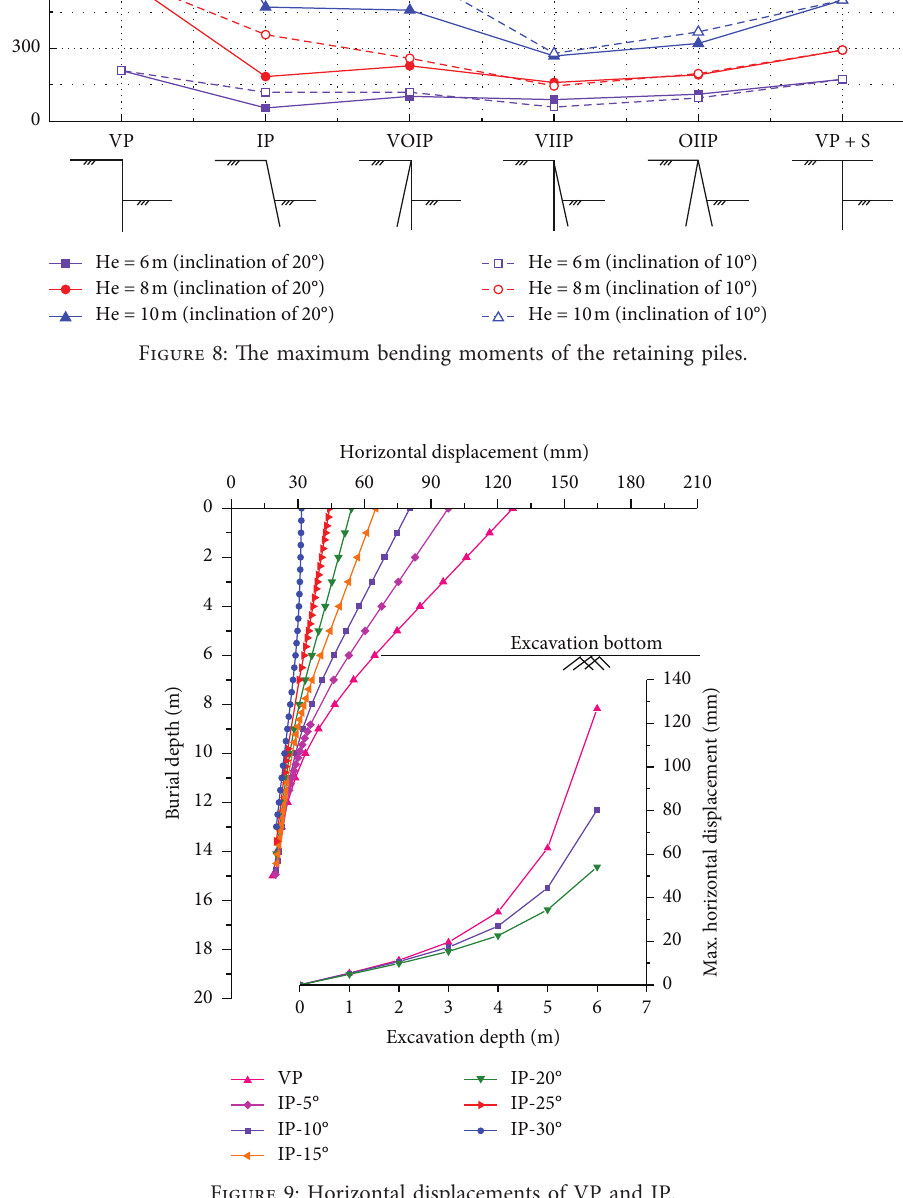
Figure 9: Horizontal displacements of VP and